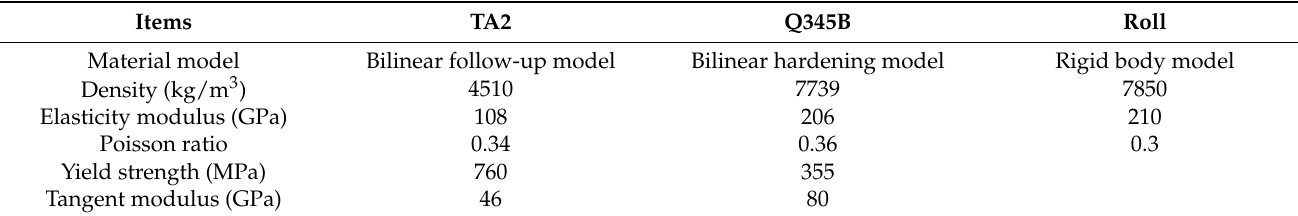
Table 2. Simulation calculation of the rolling process